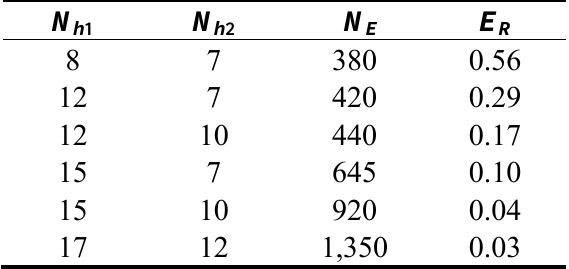
and N neurons, respectively. h 1 h 2